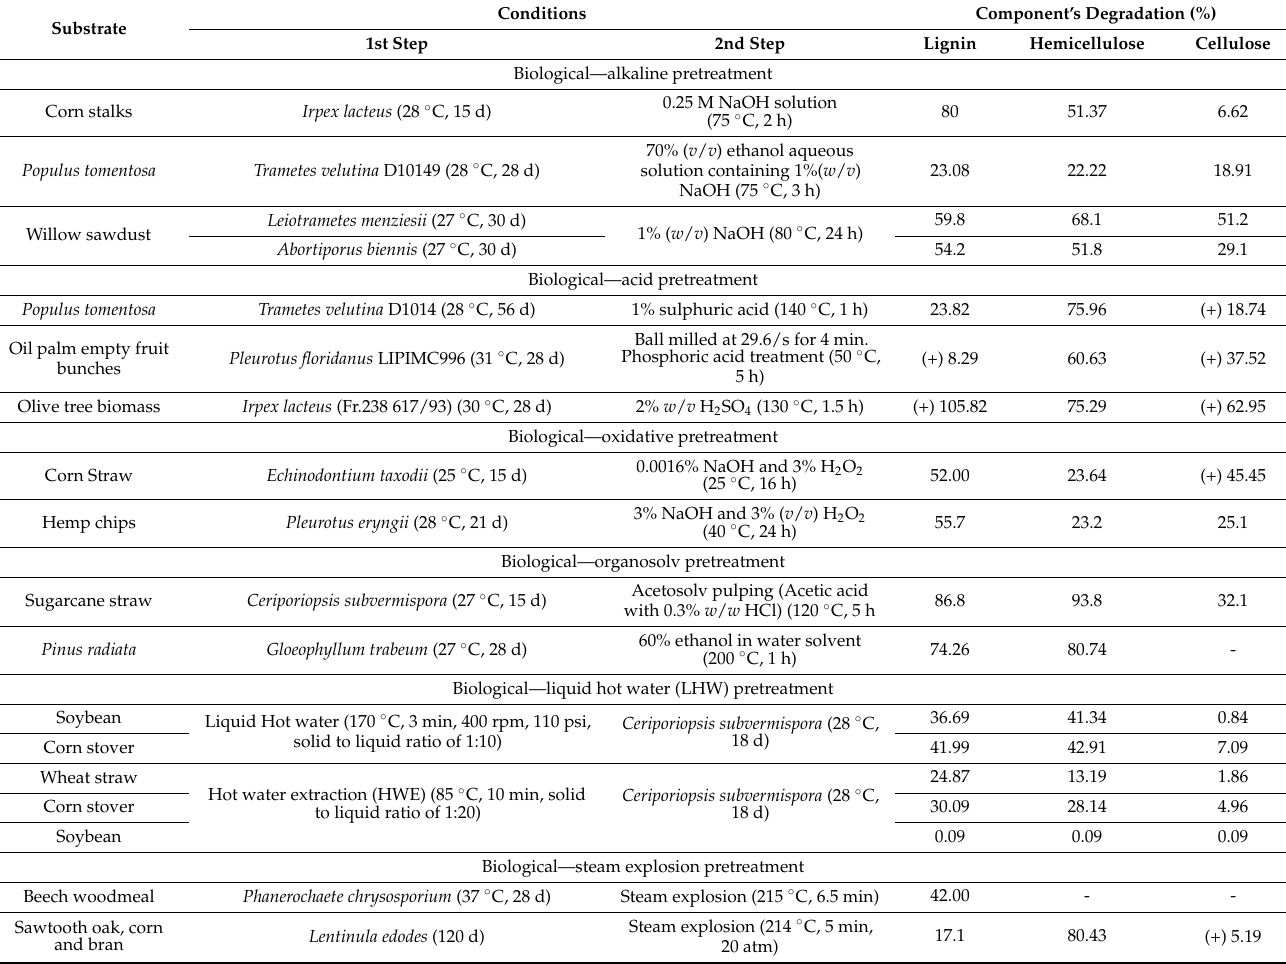
Table 3. Previous research on biological-chemical pretreatment approaches to pretreat lignocellulosic biomass. Data retrieved from Ref.